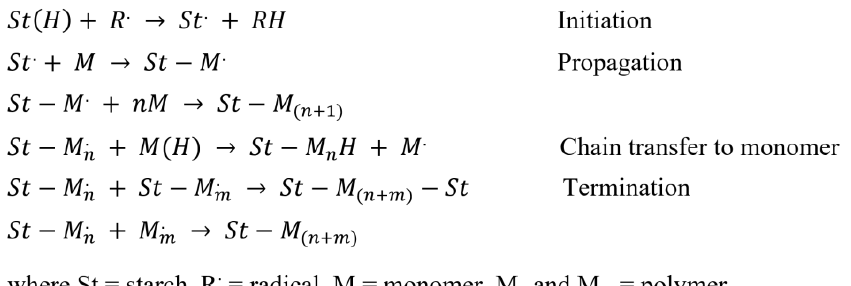
Figure 8. Initiation, propagation, chain transfer and termination mechanisms from the grafting of vinyl monomer to the starch backbone. Adapted from [119].